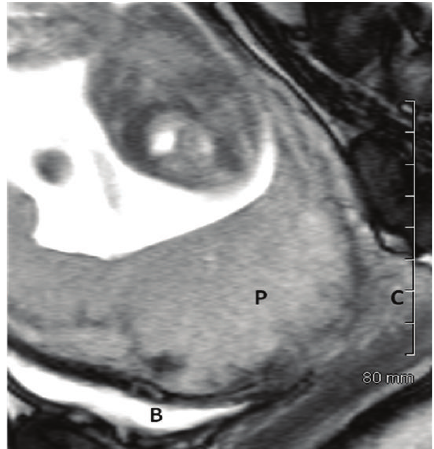
Figure 1: Magnetic resonance imaging (MRI) at 17 weeks’ gestation demonstrating focal disruption of the anteroinferior myometrium with placental invasion. P: placenta, B: bladder, and C: